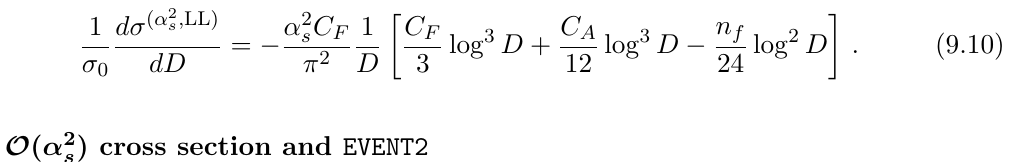
Figure 4. Comparison of analytic predictions for the distribution of the D -parameter at through single-logarithmic accuracy (dashed) to EVENT2 (solid). (a) The full logarithmic comparison exhibiting excellent agreement between analytics and EVENT2 . (b) The comparison of the prediction in region 3 to EVENT2 with the contributions from regions 1 and 2